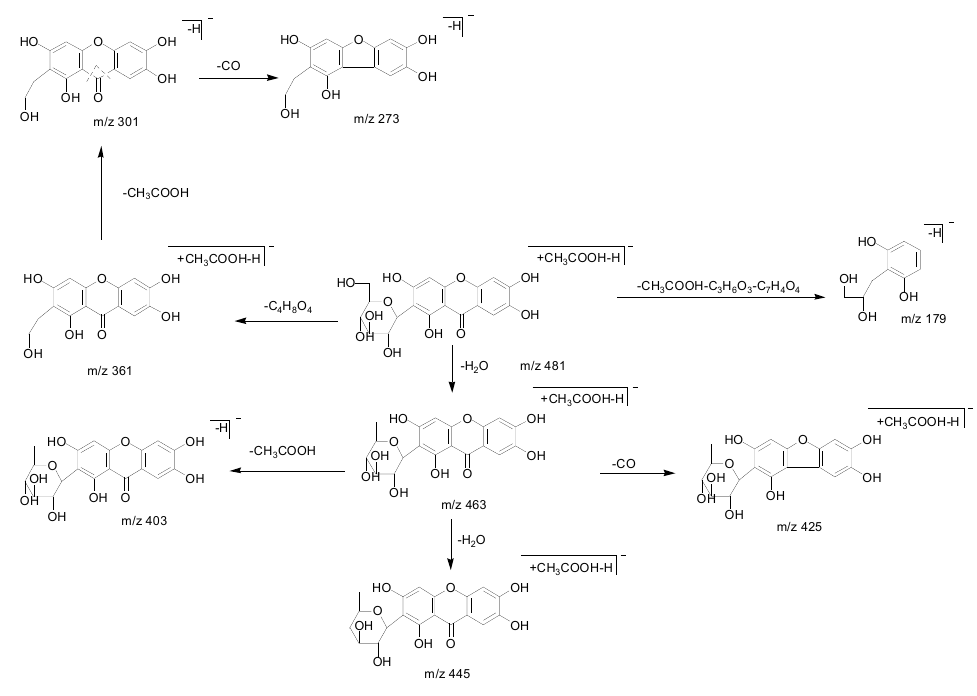
Figure 10. The proposed fragmentation pathway of mangiferin.